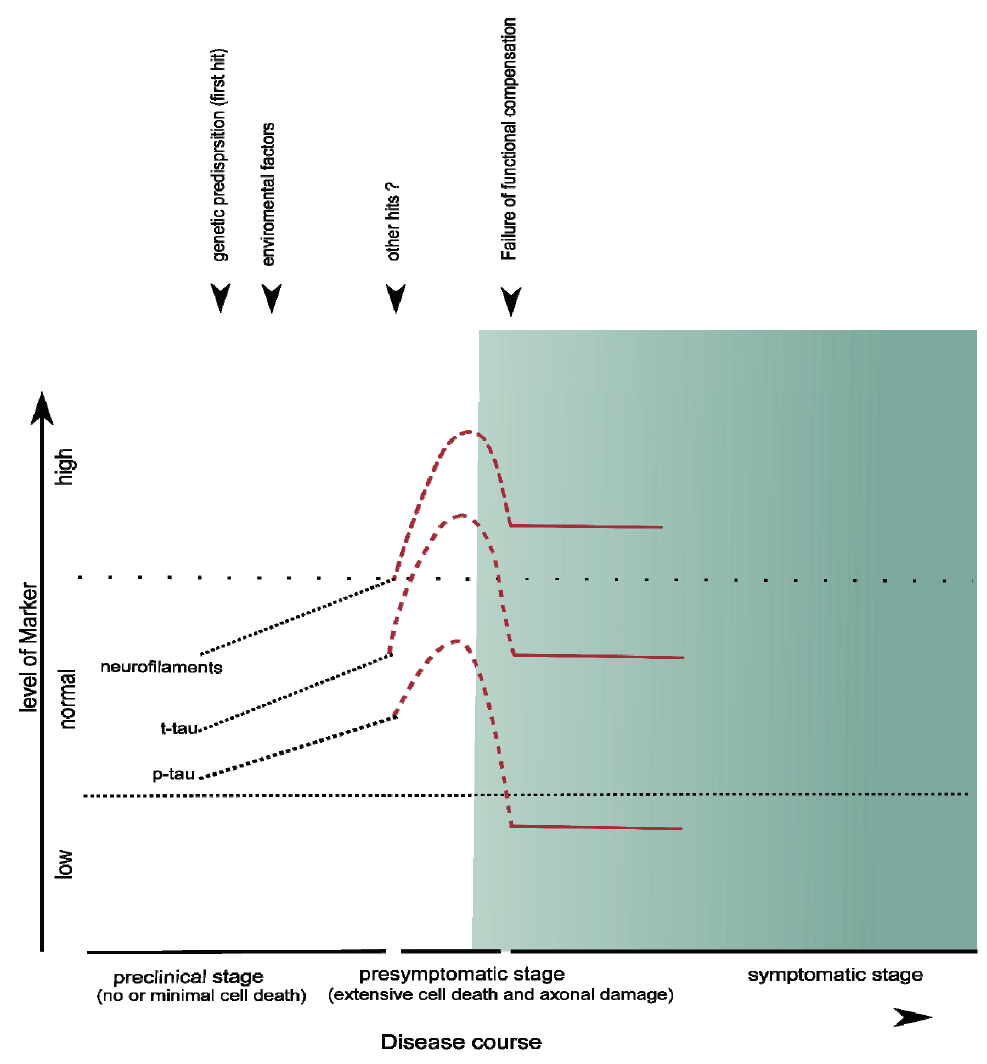
Figure 2. Dynamics of CSF-biomarkers in ALS. The long preclinical stage characterized by cellular changes like cytoplasmic vacuoles, mitochondrial changes and synaptic loss because of genetic predisposition (first hit) in addition to environmental factors and oxidative stress (other hits) would be associated with no or minimal cellular death and, thus, no or low level of marker in the CSF. In the presymptomatic stage, where extensive cell death and axonal damage takes place, there would be a massive release of CSF markers for neurodegeneration. The symptoms will appear when the damage exceeds the functional capacity of the CNS. In the symptomatic stage, the CSF levels of neurodegeneration markers do not show significant changes which can be explained by reduced volume of neuroaxonal structures. Less sensitive markers for axonal death like t-Tau will be even